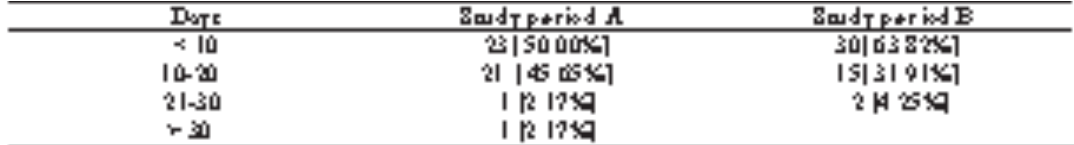
Table VIII : Hospital stay